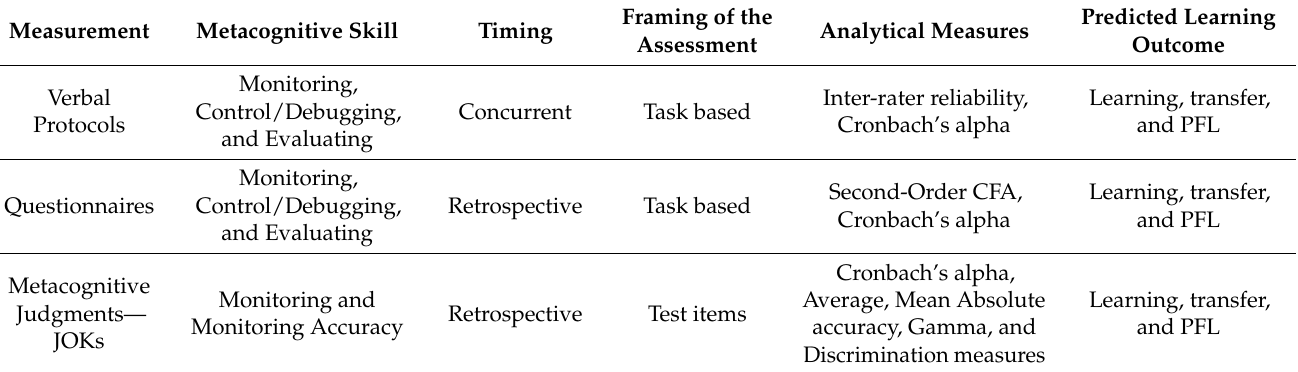
Table 1. Overview of the metacognitive regulation